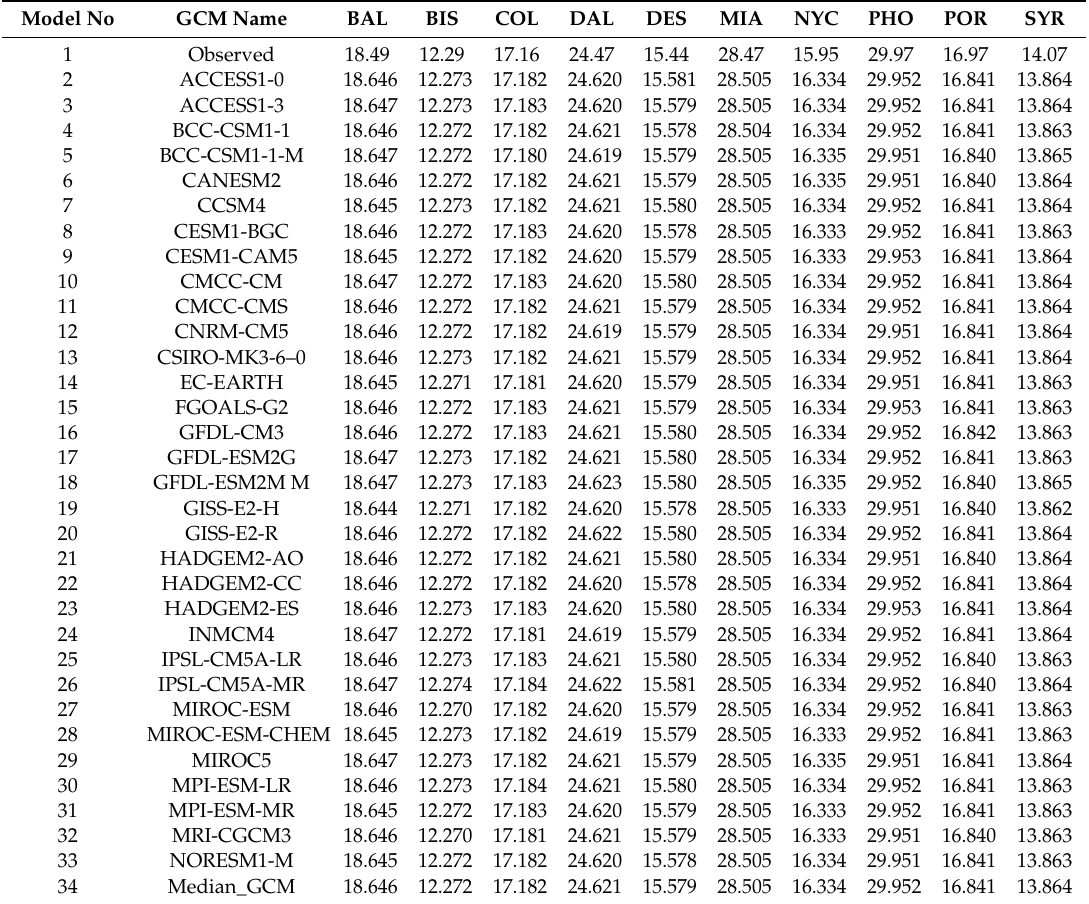
Table A1. Average observed and simulated daily maximum temperature ( ◦ C) for 1950–2005.